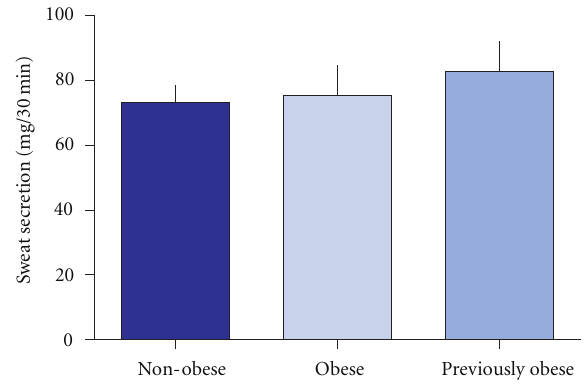
Figure 2: Twenty-four-hour GH release. Columns represent (left to right) levels in non-obese ( n = 16), obese ( n = 16), and previously obese subjects ( n = 8).